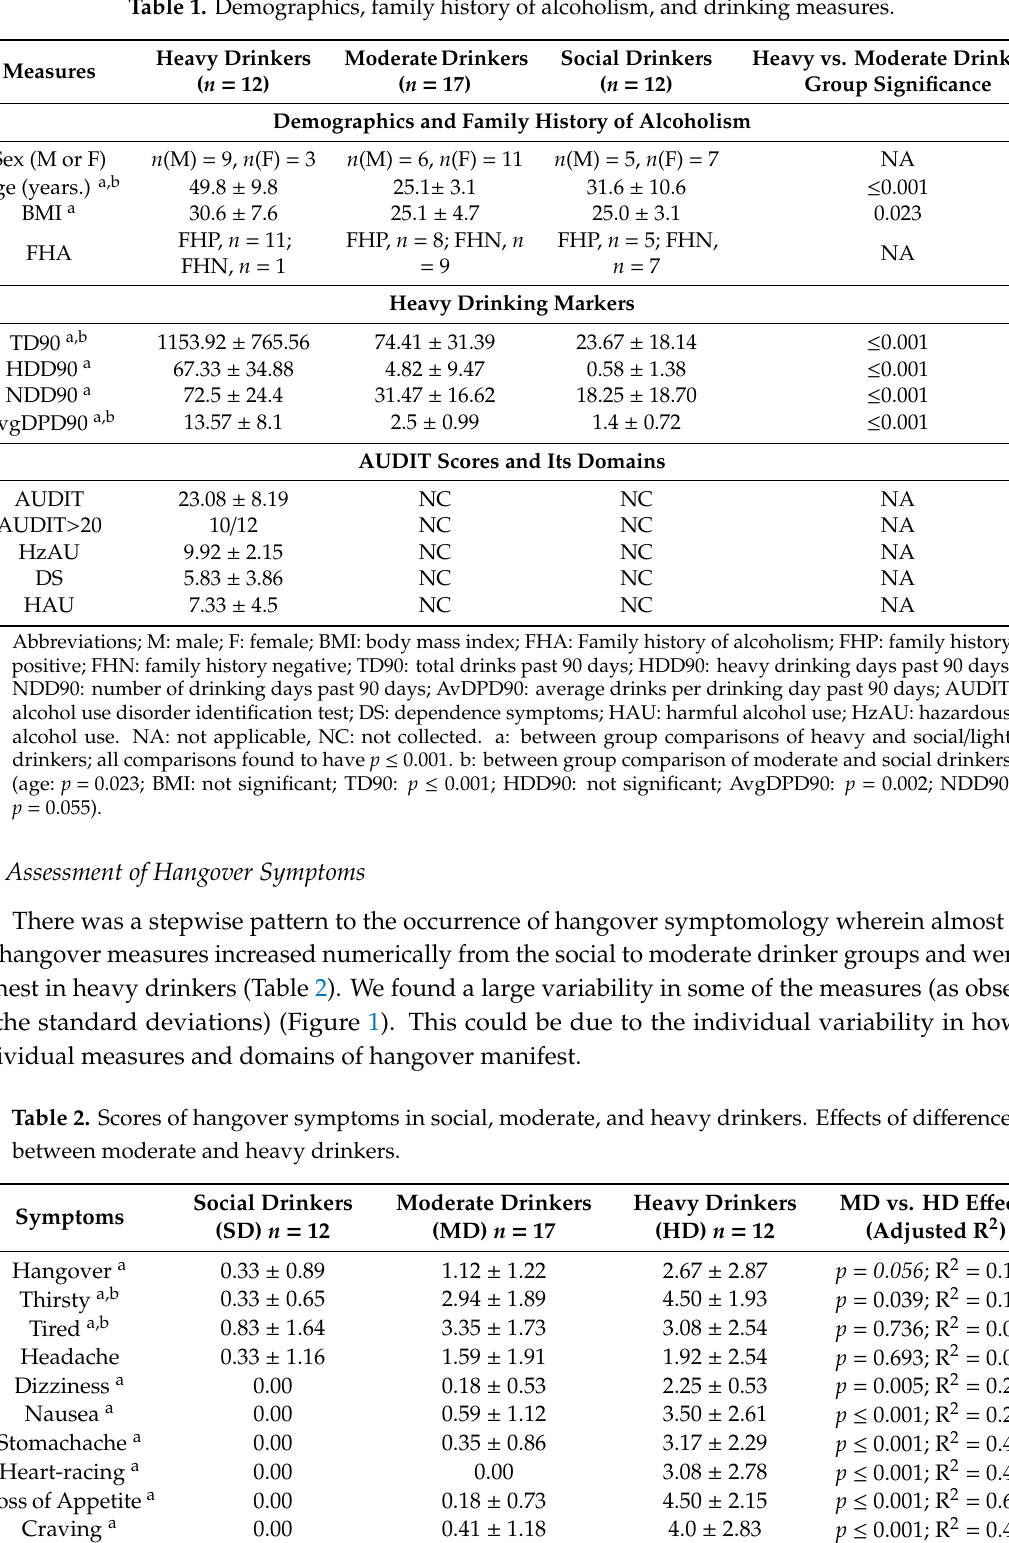
Table 1. Demographics, family history of alcoholism, and drinking measures.